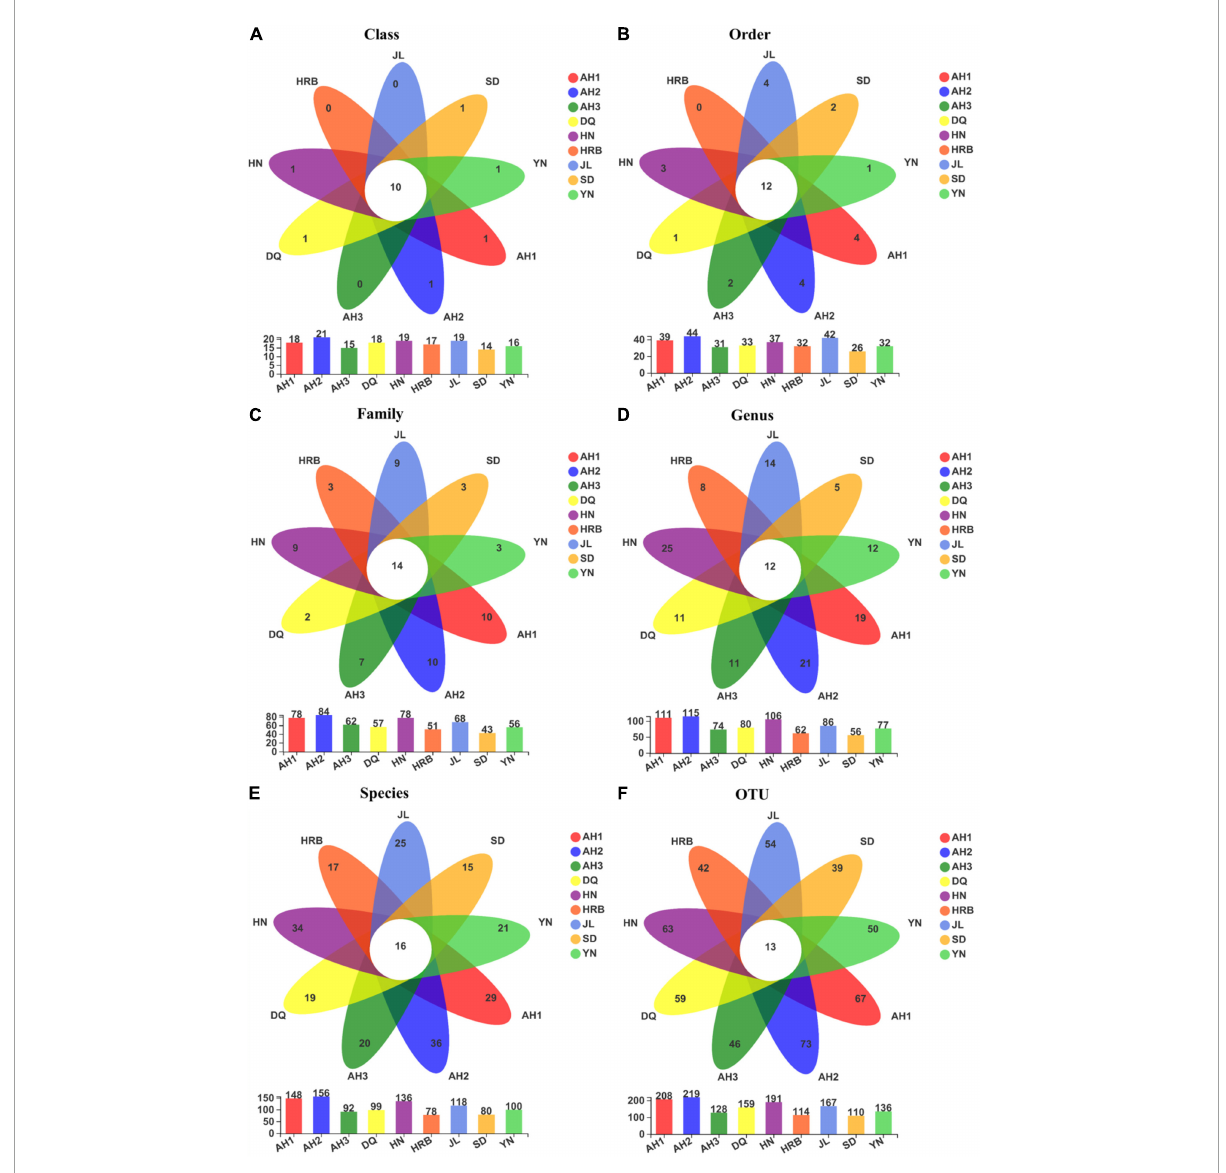
FIGURE7 (A–F) Overlap in fungal community composition at different taxonomic levels among the nine geographic populations of the hemp flea beetle P. attenuata in China, with the number of fungi unique to each population in the petal and the number of fungi common to all populations in the center. Below is a bar chart of the total number of species in each population at selected taxonomic